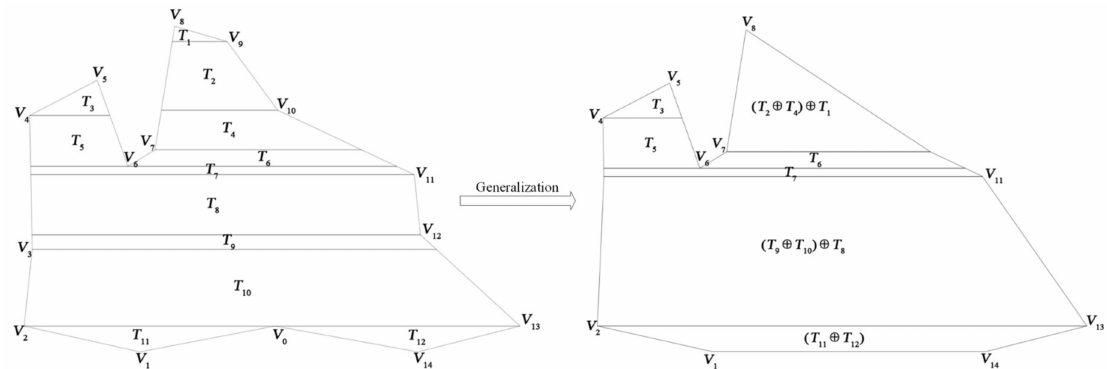
Figure 3. Simplifying a trapezoidal mesh via trapezoidal